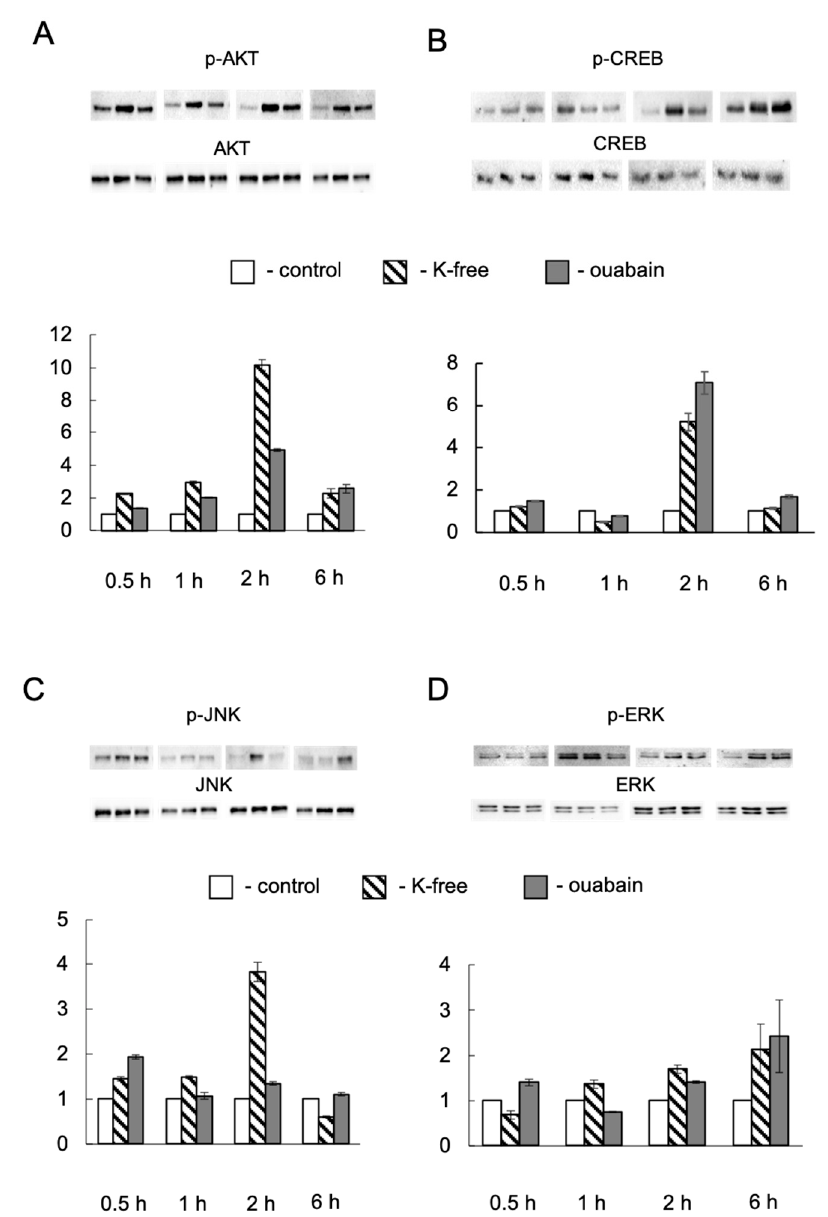
Figure 6. Representative western blots and relative content of phosphorylated Akt ( A ), CREB ( B ), JNK ( C ), and Erk ( D ) in control HUVEC and after 0.5-, 1-, 2-, and 6-h exposure to 3 µ M ouabain or K + -free medium. The content of proteins in control cells was taken as 1.0. Data obtained in three independent experiments are reported as means ± S.E.